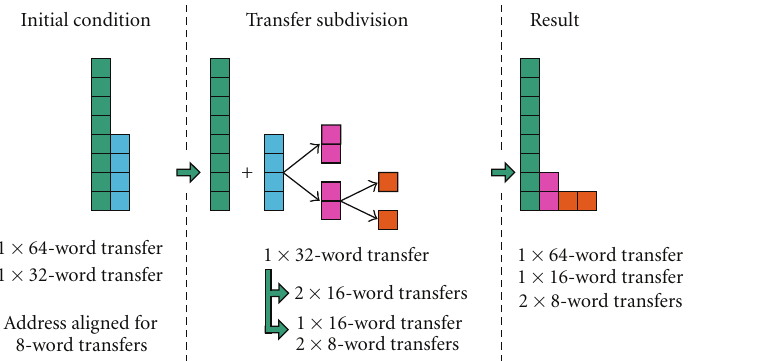
Figure 3: Transfer subdivision example.